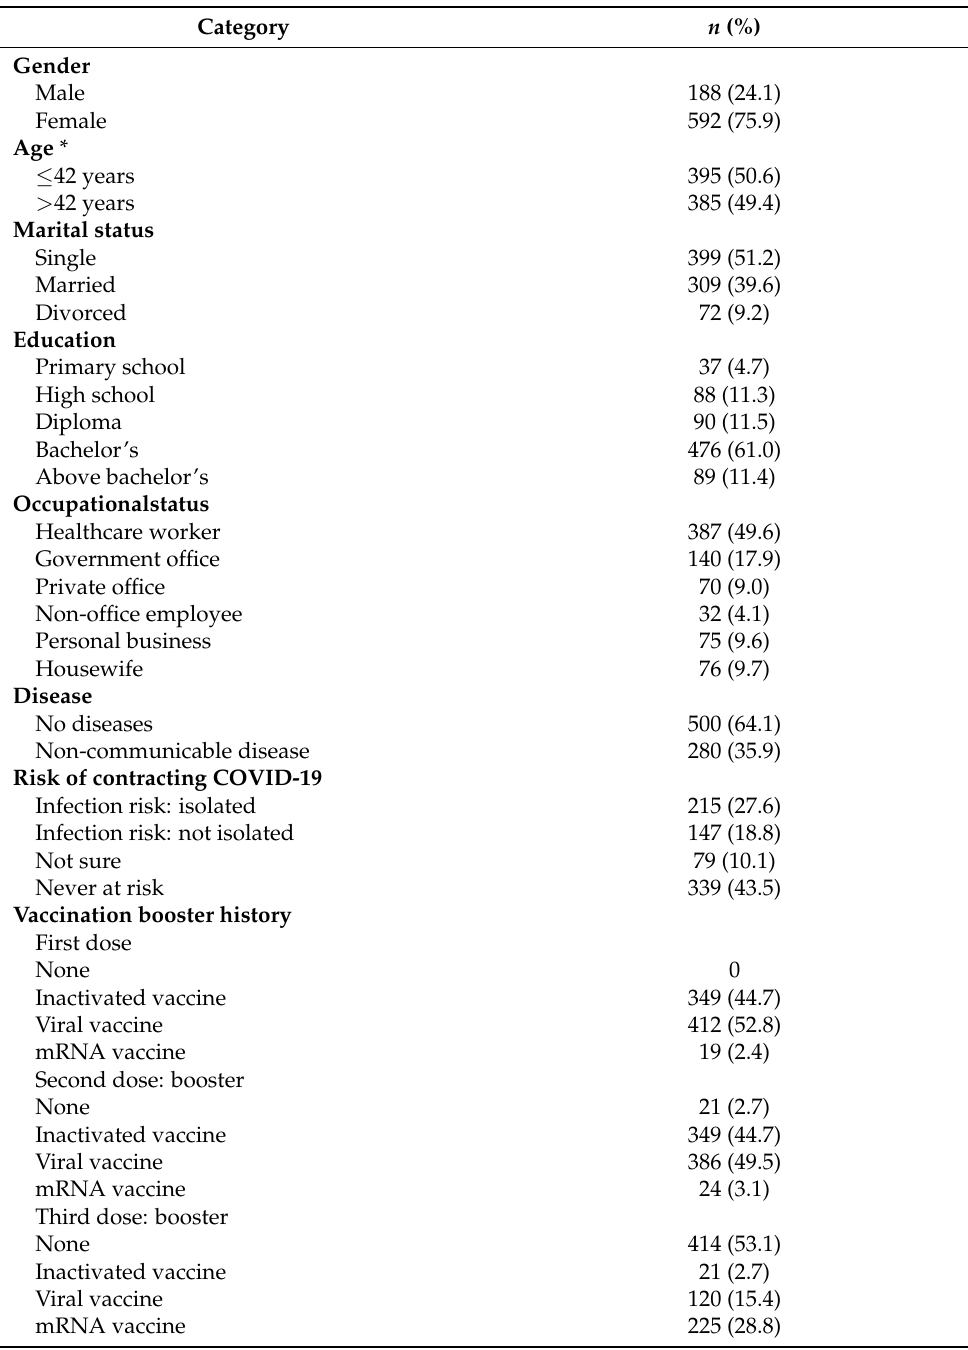
Table 1. Socio-demographic characteristics of participants ( n =